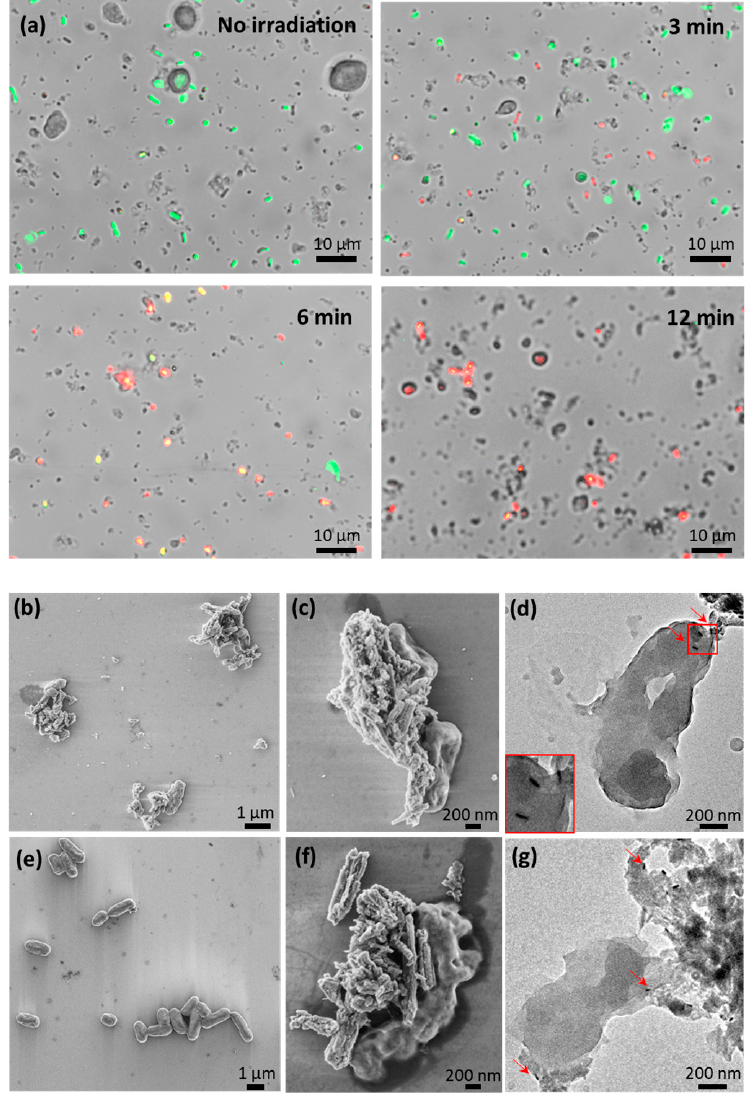
Figure 5. Light and electron microscopy imaging of the antibacterial photothermal effect exerted by AuNR-Ab-HNTs hybrids—mixtures containing AuNR-Ab-HNTs hybrids and E. coli irradiated using a 808 nm laser (4 W cm − 2 ) and imaged using ( a ) overlay of bright-field and fluorescence microscopy after irradiation time of 0, 3, 6, and 12 min (upper panel left to right and bottom panel left to right, respectively). Bacteria were labeled with Live/Dead staining: Green—Syto9, Red—propidium iodide; ( b , c , f ) SEM for 12 min irradiation; and ( d , g ) TEM for 12 min irradiation. (High contrast gold nanorods are indicated by red arrows. The red frame inset depicts higher magnification of the region of interest marked with a red rectangle.) ( e ) SEM micrograph of untreated E. coli cells. The selectivity of the photothermal activity of the AuNR-Ab-HNTs hybrids was investigated with two non-target bacteria species: Serratia marcescens (Gram negative) and Staphylococcus epidermidis (Gram positive), and the results are depicted in Figure 6. It is evident that the irradiated AuNR-(anti- E. coli ) Ab-HNTs hybrids exhibited an order of magnitude higher potency against the target bacteria ( E. coli ), in comparison to the non- target bacterial cells. Therefore, we conclude that the photothermal antibacterial activity of gold nanorods could be selectively enhanced by their incorporation onto antibody- functionalized